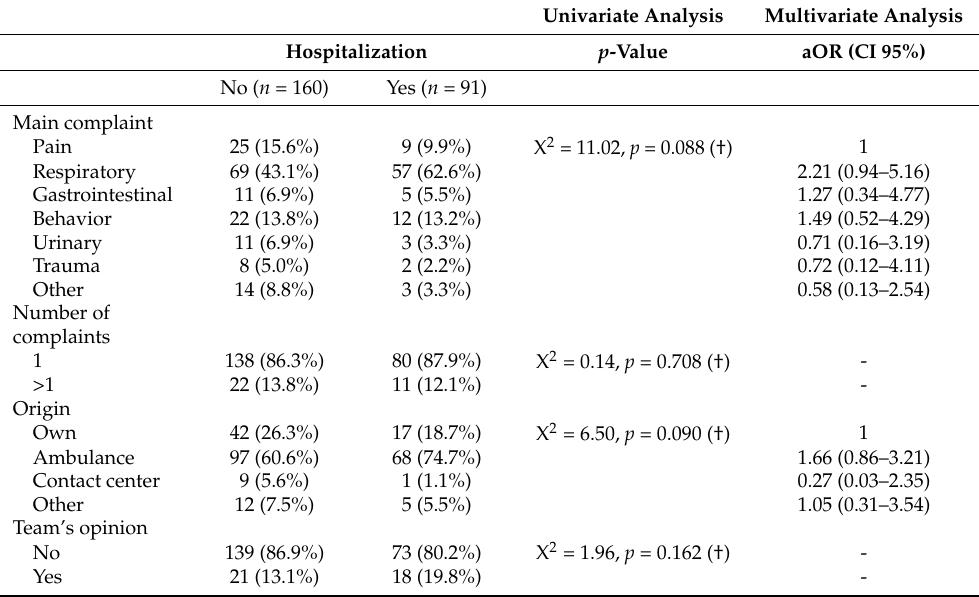
Table 7. Associations with hospitalization during an episode in the emergency department.